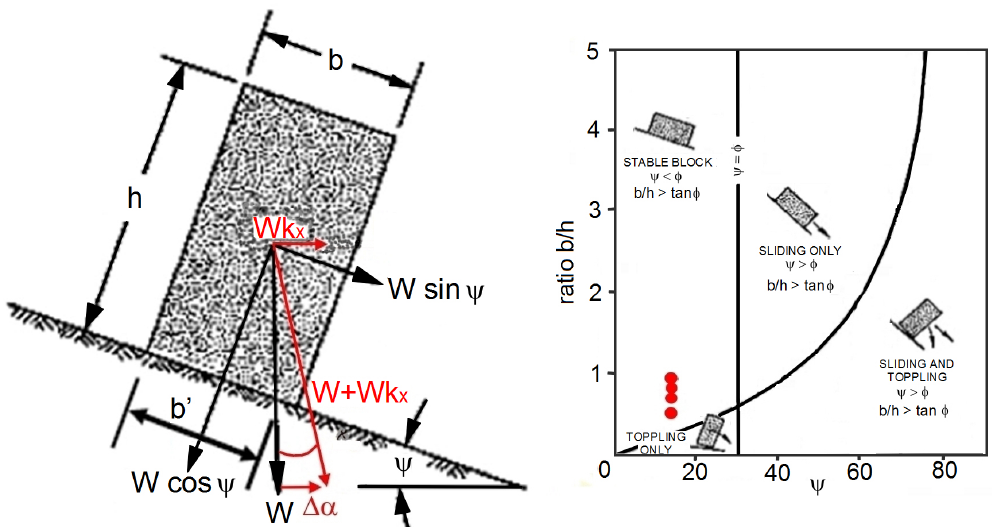
Fig. 8. Stability chart for rock topples (modified from Goodman and Bray, 1976); the red circles correspond to the rock blocks of the Mt. Pucci cliff